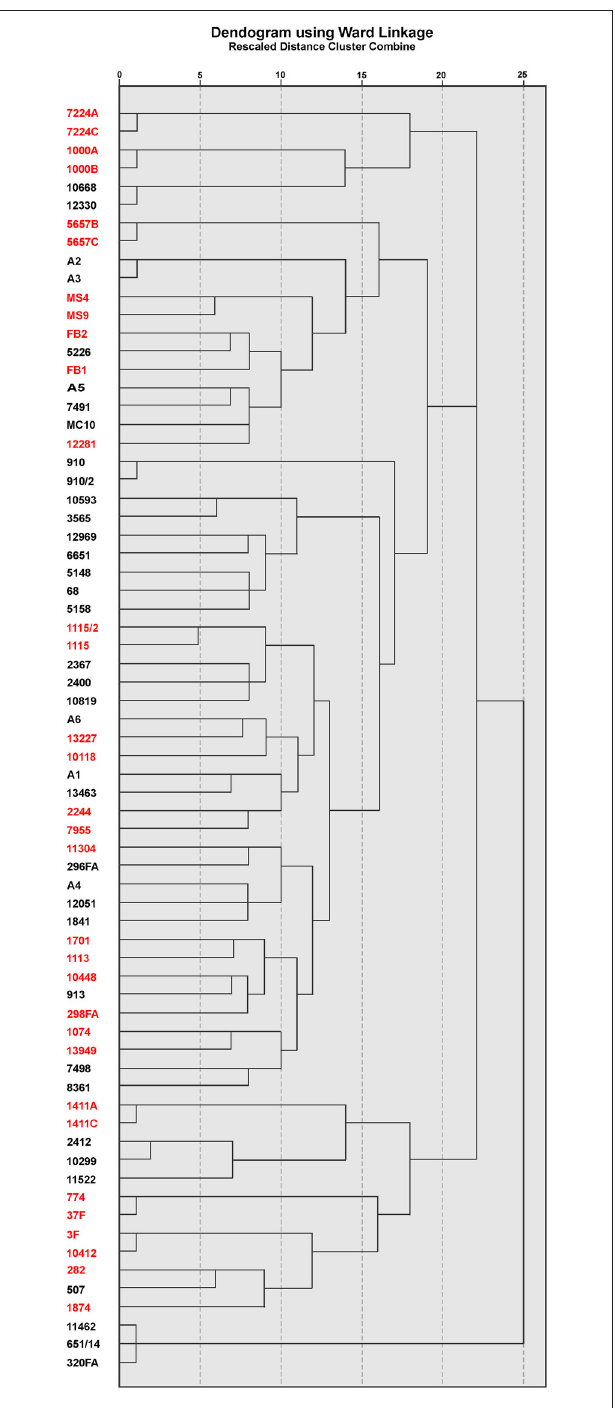
FIGURE 2 | Dendrogram created according to PFGE profile of Xba I digested genomic DNA of CF (red) and non-CF (black) Achromobacter spp.